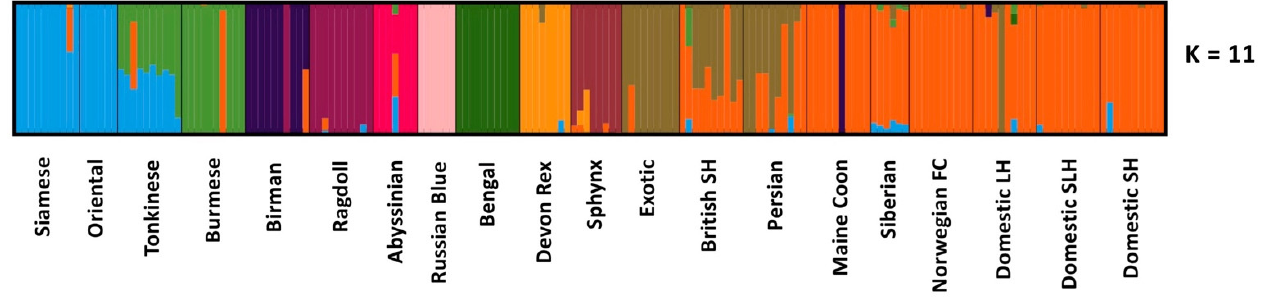
Figure 2. fastSTRUCTURE analysis on the balanced dataset. Each column represents an individual cat. Each cluster (K) is represented by a unique colour. The model component used to explain structure in the dataset ( K ∅ c ) was K = 11.